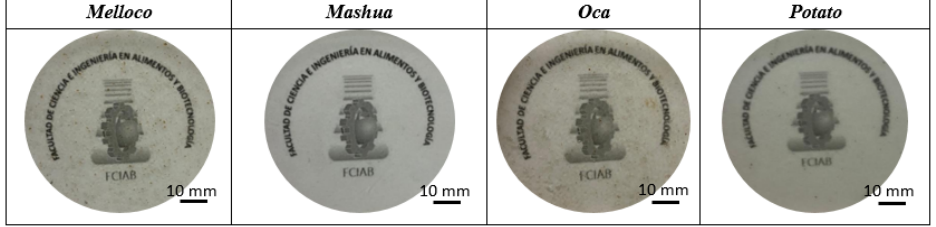
Figure 1. Visual appearance and apparent transparency of starch films extracted from each Andean tuber analyzed.